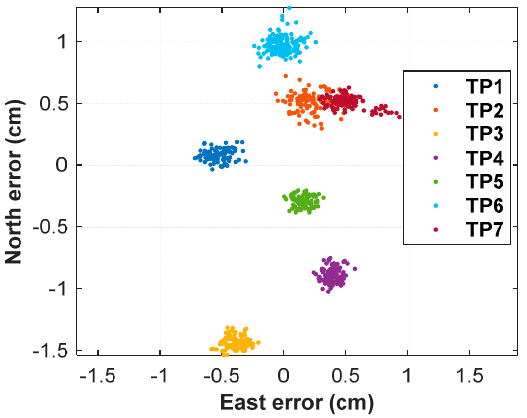
Figure 15. Positioning errors corresponding to seven TPs (test points). Table 8. Statistics of position results of seven TPs.